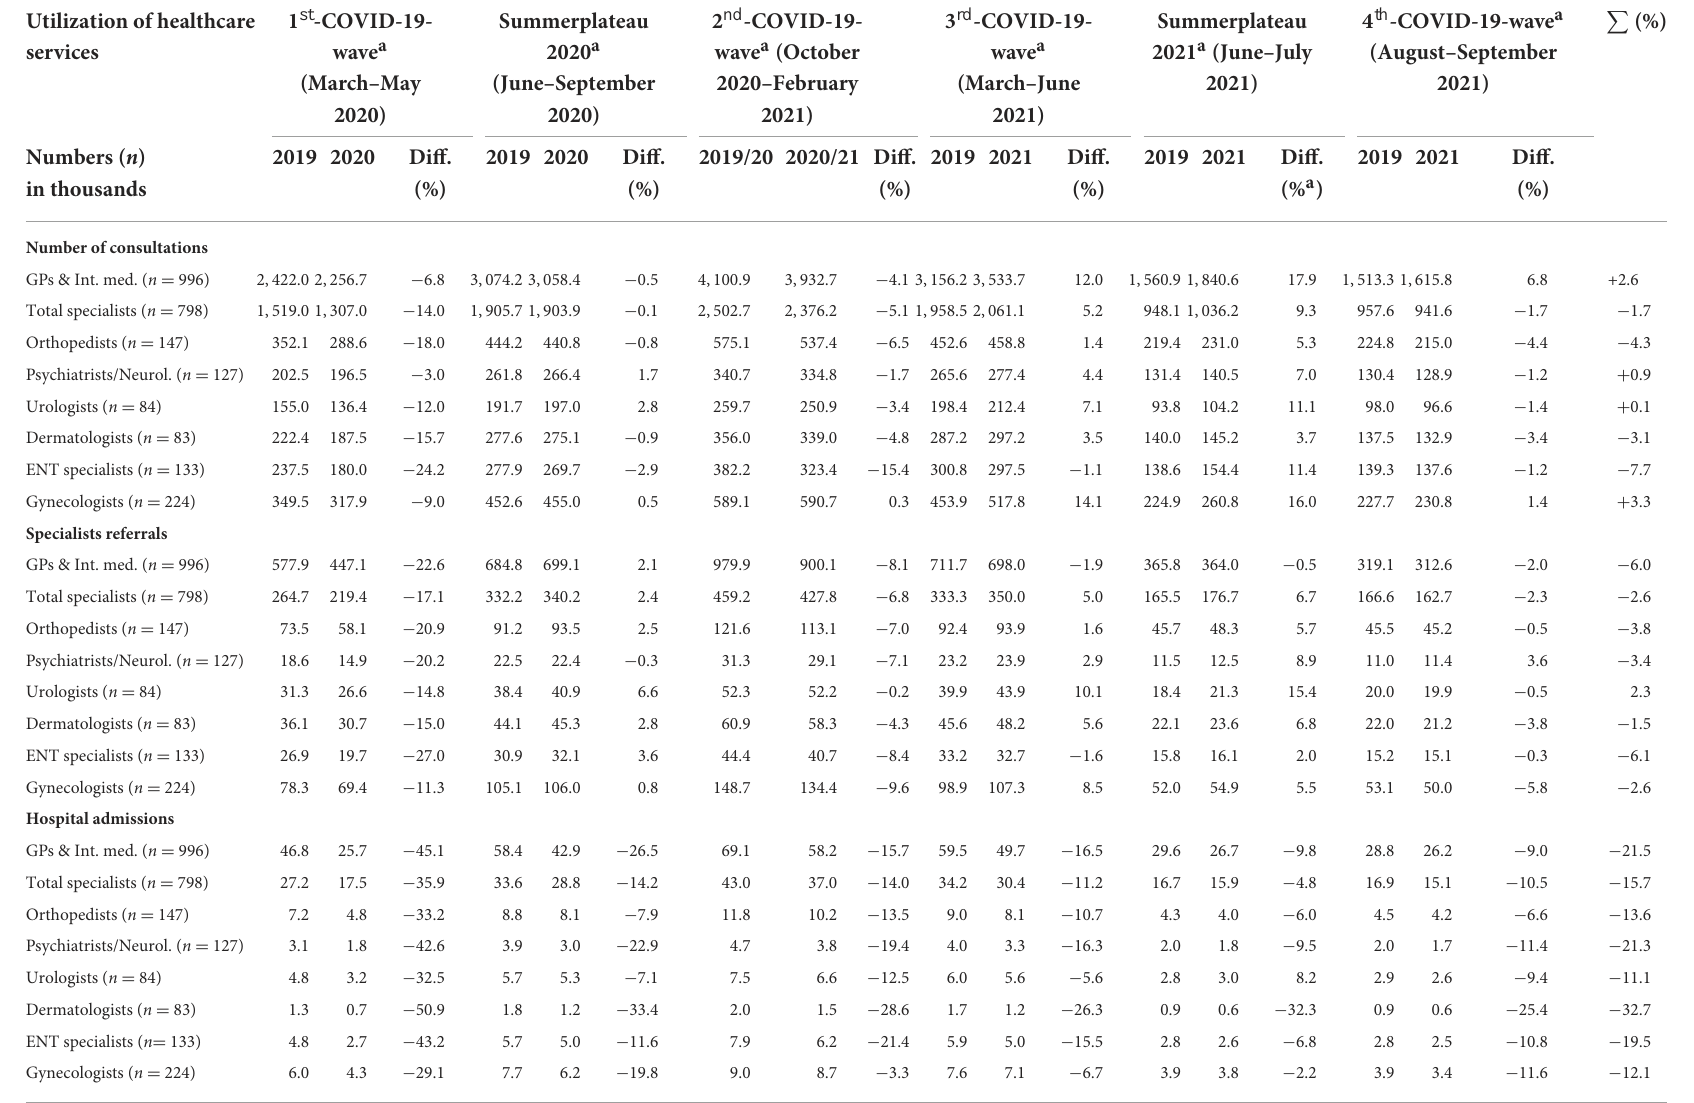
TABLE 1 Utilization of healthcare services during the COVID-19 pandemic in Germany compared to the pre-pandemic time frame